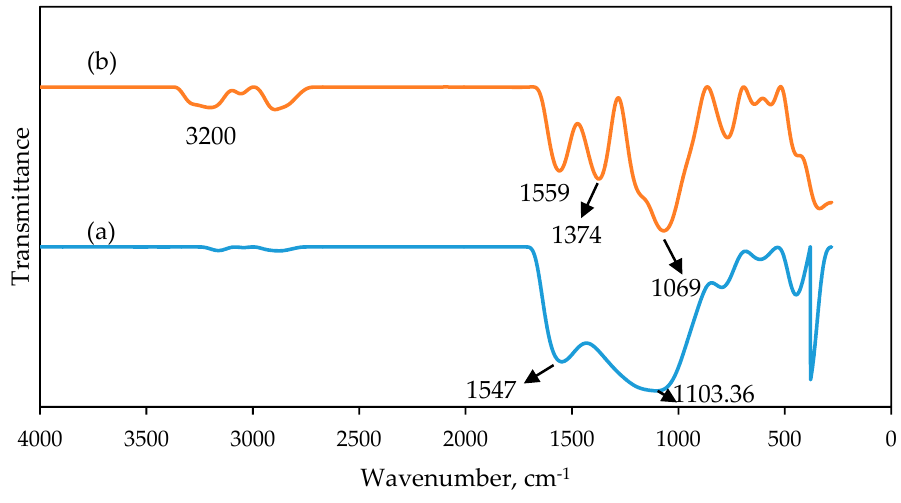
Figure 6. FTIR spectra of ( a ) PAN/SL CNFs and ( b ) PAN/SL ACNFs.